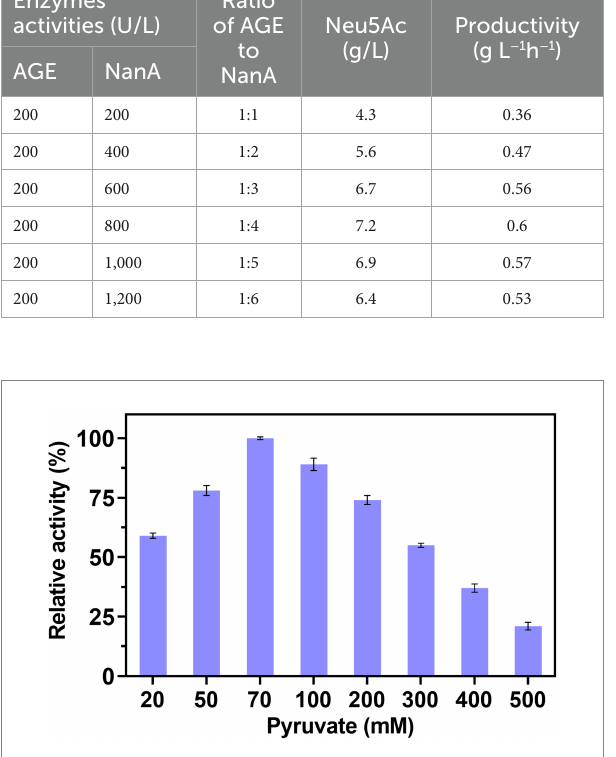
TABLE 2 Effect of ratio of AGE to NanA on the yield and productivity of the multi-enzyme cascade catalyzed synthesis. Enzymes Ratio activities (U/L) of AGE